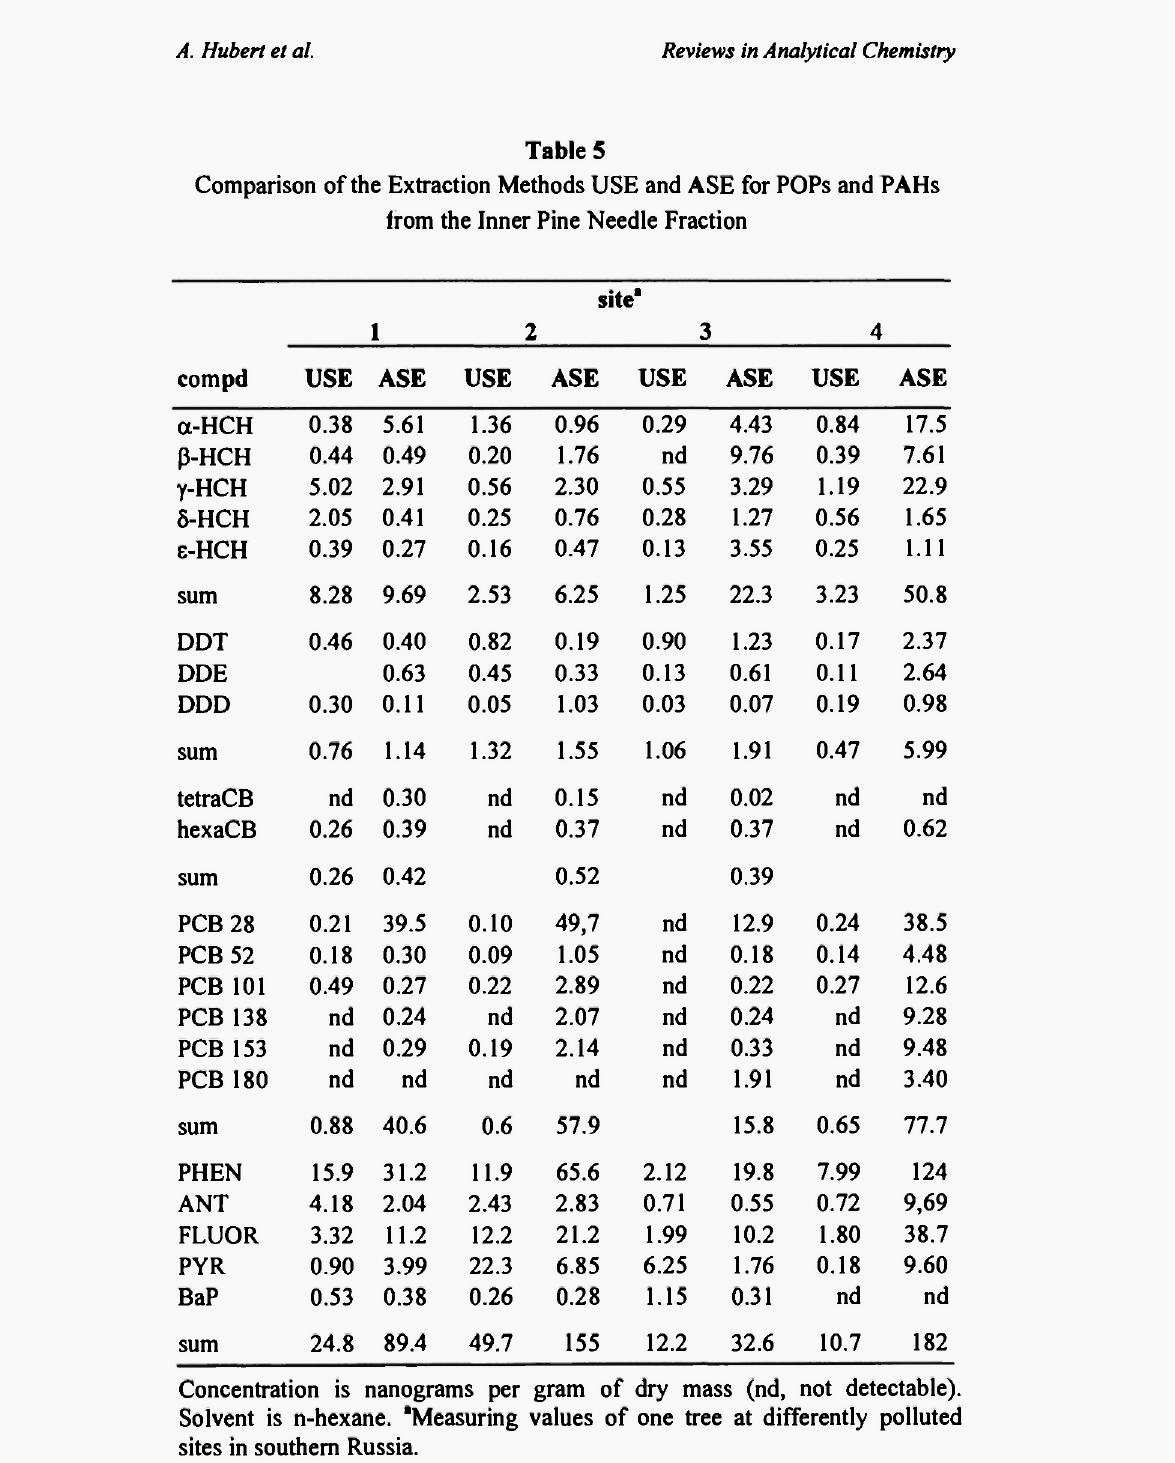
Comparison of the Extraction Methods USE and ASE for POPs and PAHs from the Inner Pine Needle